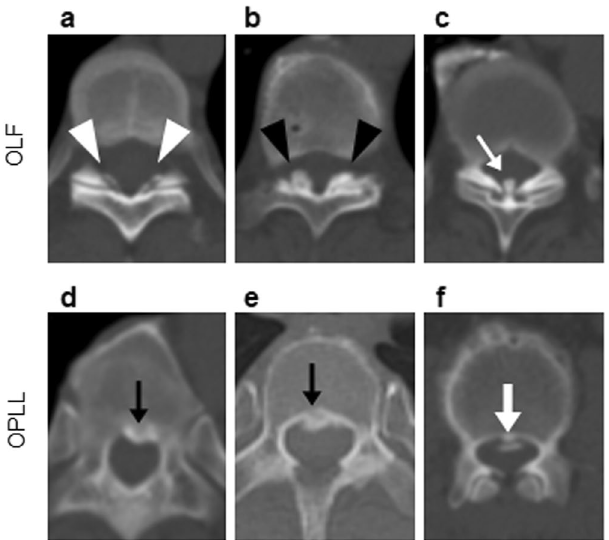
Figure 2. Criteria for the identification of OLF and OPLL on computed tomography. ( a ) OLF that is clearly visible but less than 3 mm in thickness (white arrowheads). ( b ) OLF with an apparent thickness of 3 mm or more (black arrowheads). ( c ) A mushroom-shaped OLF that is localized at the center of the laminae (white arrow). ( d,e ) OPLL with an apparent thickness of 2 mm or more (black arrow). ( f ) OPLL that is small but with a thickness of 2 mm or more (bold white arrow). OLF, ossification of the ligamentum flavum; OPLL, ossification of the posterior longitudinal